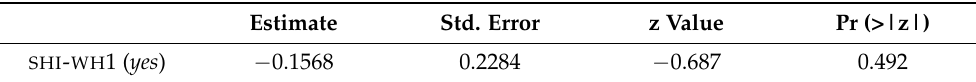
Table 14. Cumulative link mixed model fitted with the Laplace approximation. (Sub-experiment 4’ | Specific-Adjunct.)